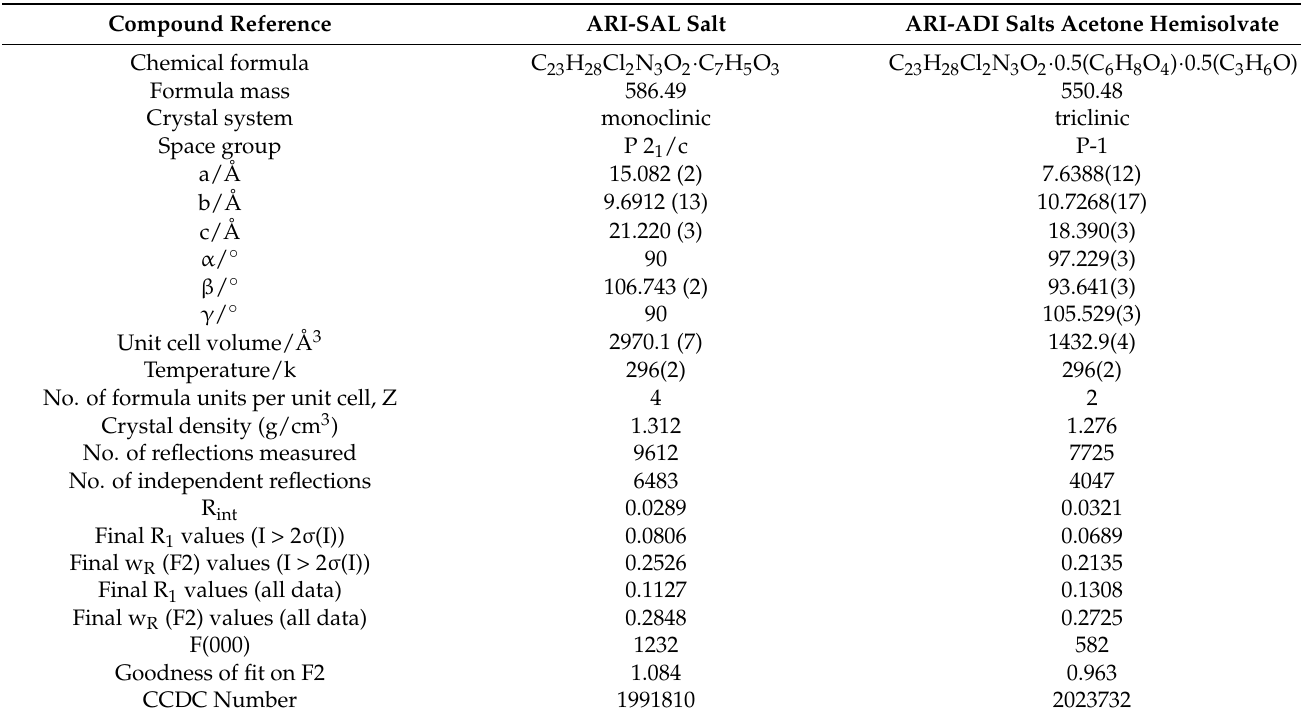
Table 1. Crystallographic data of two multicomponent crystals of